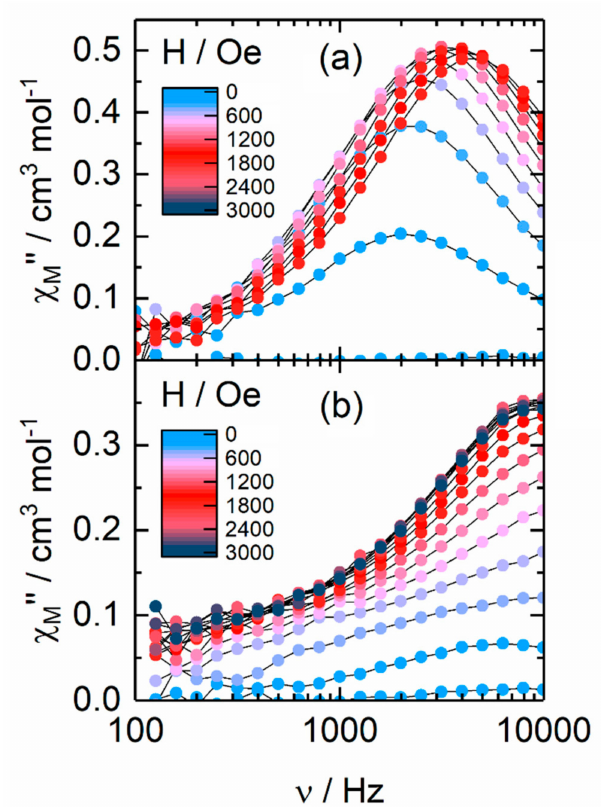
Figure 4. Frequency dependence of χ M ” between 0 and 3000 Oe for H 2 SQ-Yb ( a ) and Q-Yb ( b ) at